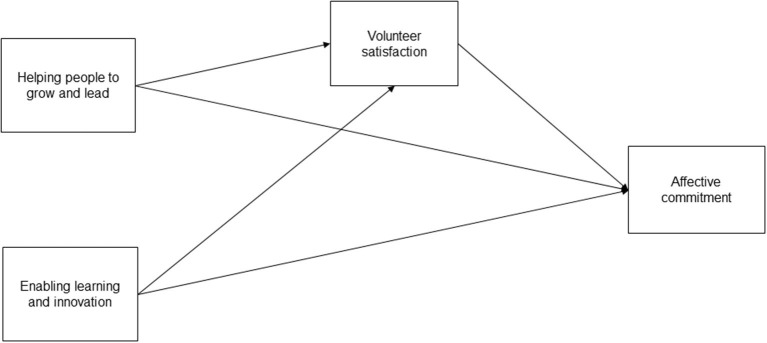
Theoretical model.